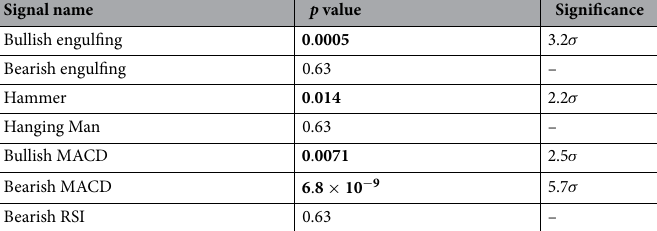
Table 2. Statistical significance of each technical indicator is shown in terms of their global p value (averaging over multiple values of (cid:31) t ). Statistically significant p values (those < 0.1 ) are shown in bold, and for those indicators we also give the significance in terms of their σ (equivalent to a Z